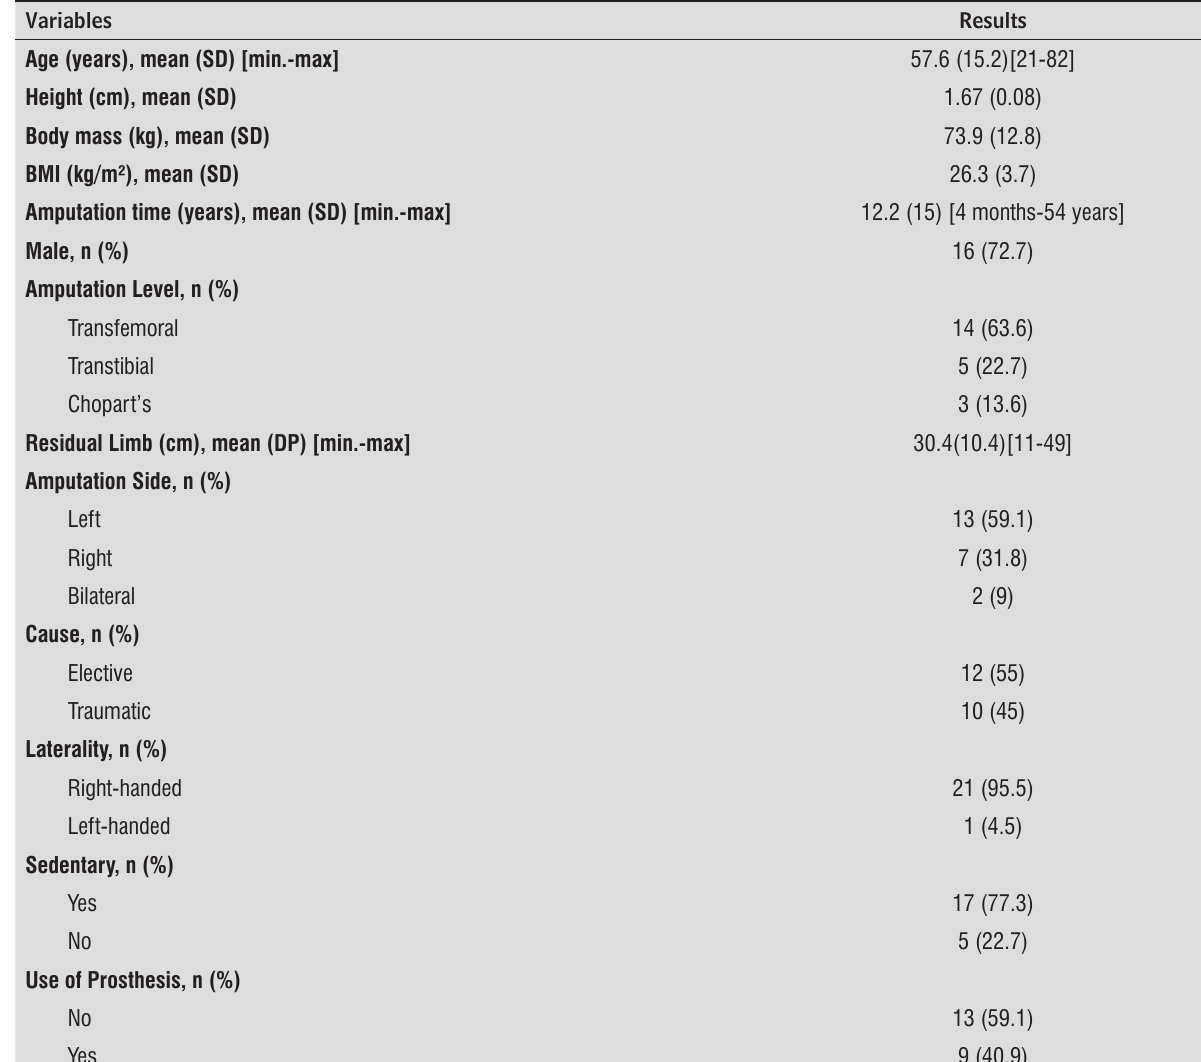
Table 1 - Demographic and clinical data (n = 22) Variables Results